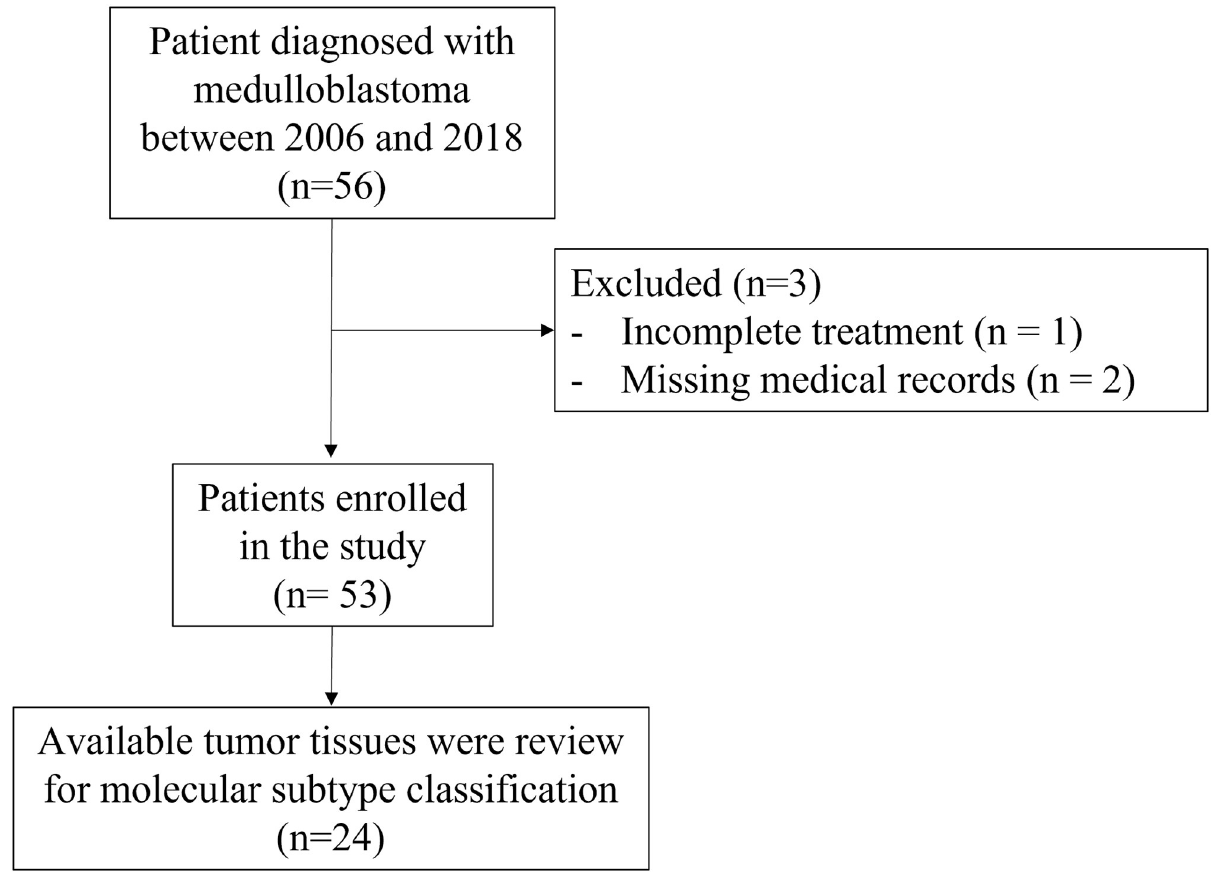
Fig 1. The participants’ flow